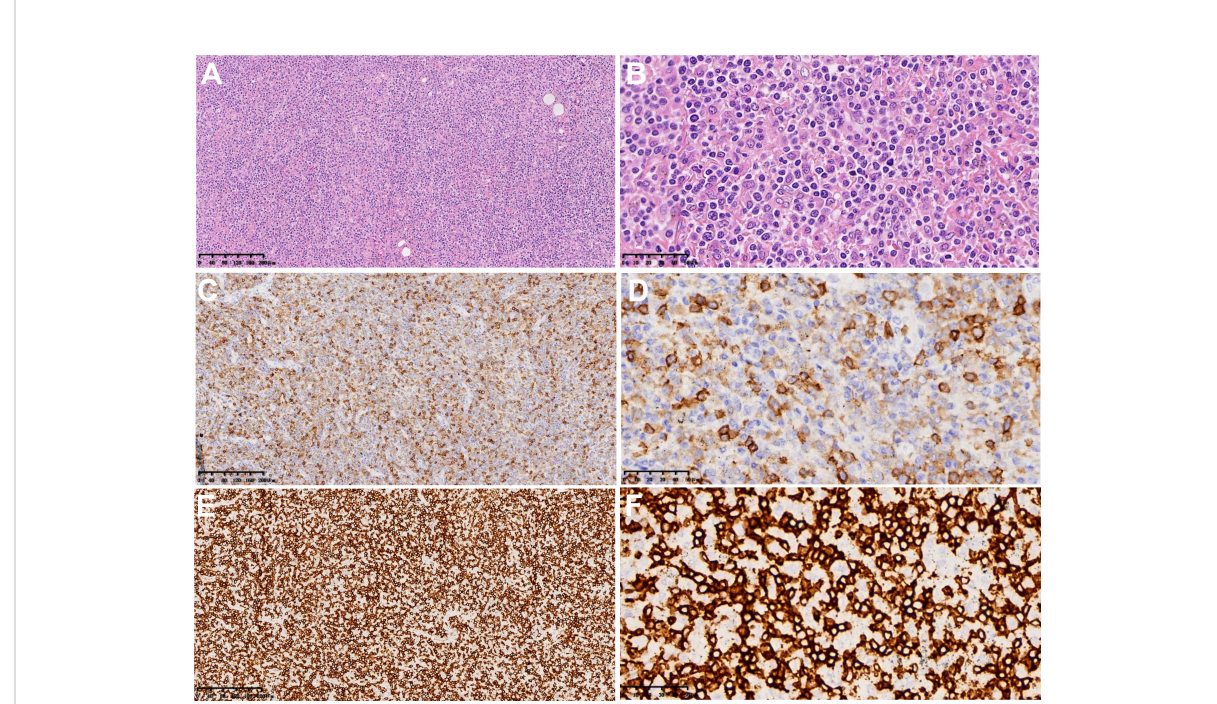
FIGURE 2 Microscopic fi ndings and immunohistochemistry of surgical pathological specimens: lymphoid cells in fi ltrated the blood vessel wall in tumor tissue, B lymphocytes scattered in the background of abundant T lymphocytes, and T lymphocytes heteroplasia, with CD8-positive cells as the host. (A, B) Hematoxylin-eosin staining (×100 and ×400). (C, D) Immunohistochemical results of CD4 (×100 and ×400). (E, F) Immunohistochemical results of CD8 (×100 and